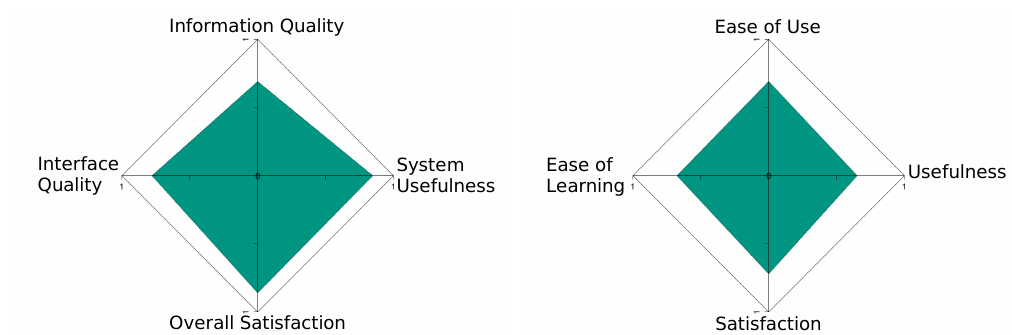
Figure 3. Radar Plots of the Evaluation Scores. Left: CSUQ, Right: USE